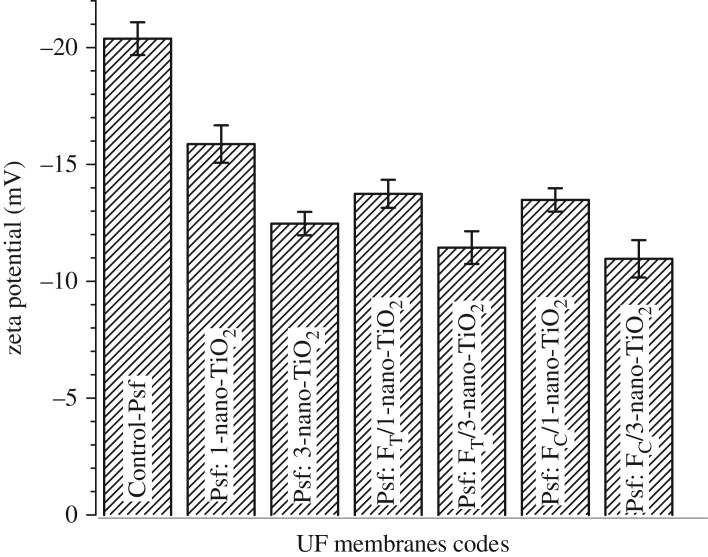
Electrokinetic features of membranes: Control-Psf UF, Psf: nano-TiO2 UF, Psf: FT-nano-TiO2 UF and Psf: FC-nano-TiO2 UF.